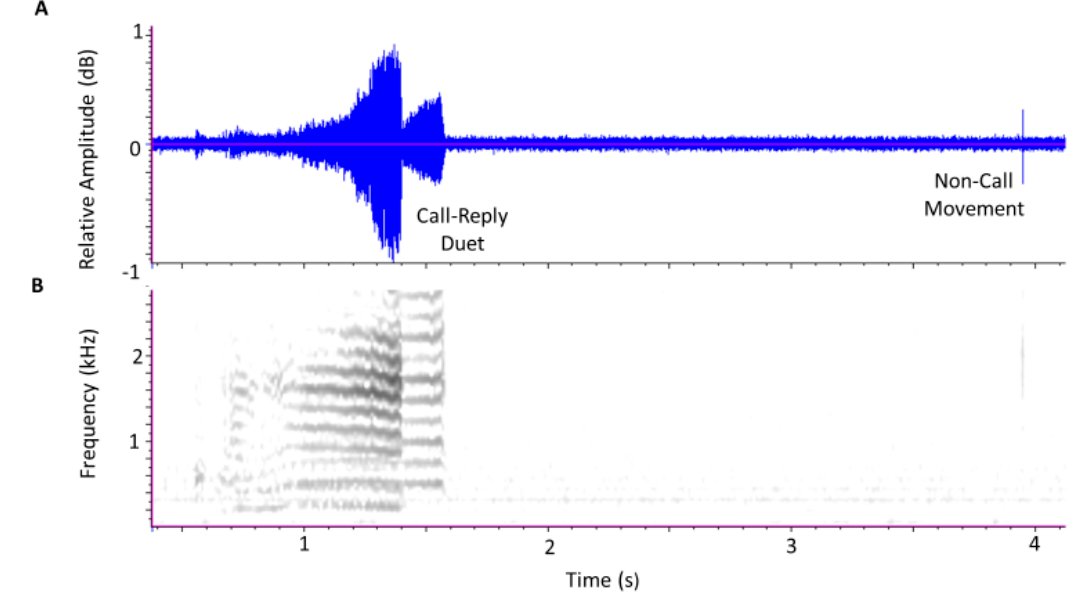
Figure 3. Oscillogram ( A ) and spectrogram ( B ) of a 4 s interval containing a Diaphorina citri call–reply duet and a non-call movement vibration. The spectra in the call–reply pulse train matched the D. citri profiles in Figure 2 but the spectra in the non-call pulse train failed to match either profile, and the pulse train was classified as a non-call movement.